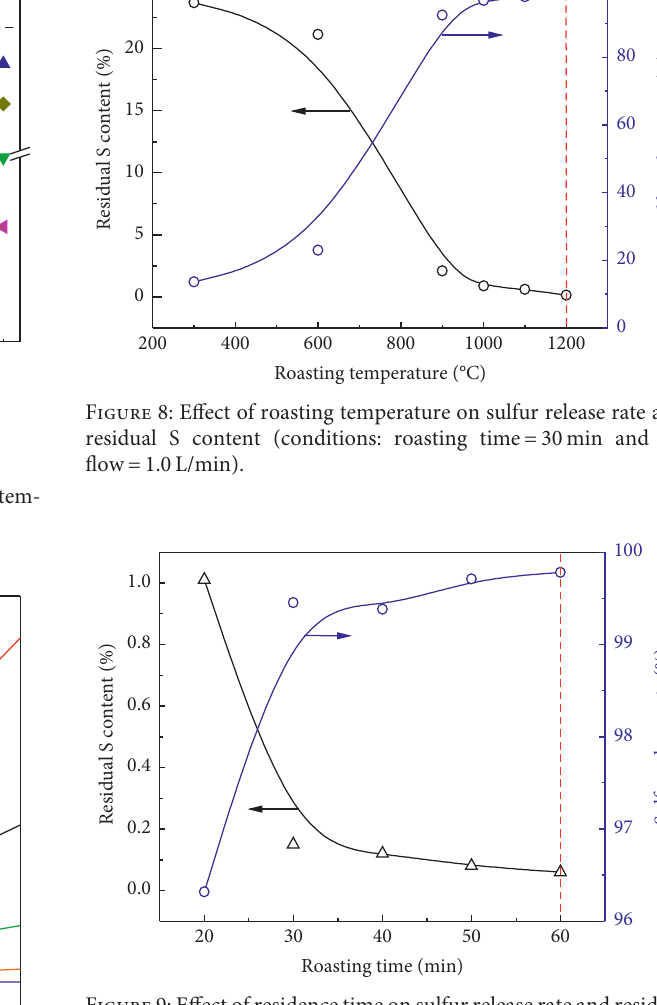
a . Fe 2 O 3 and FeS